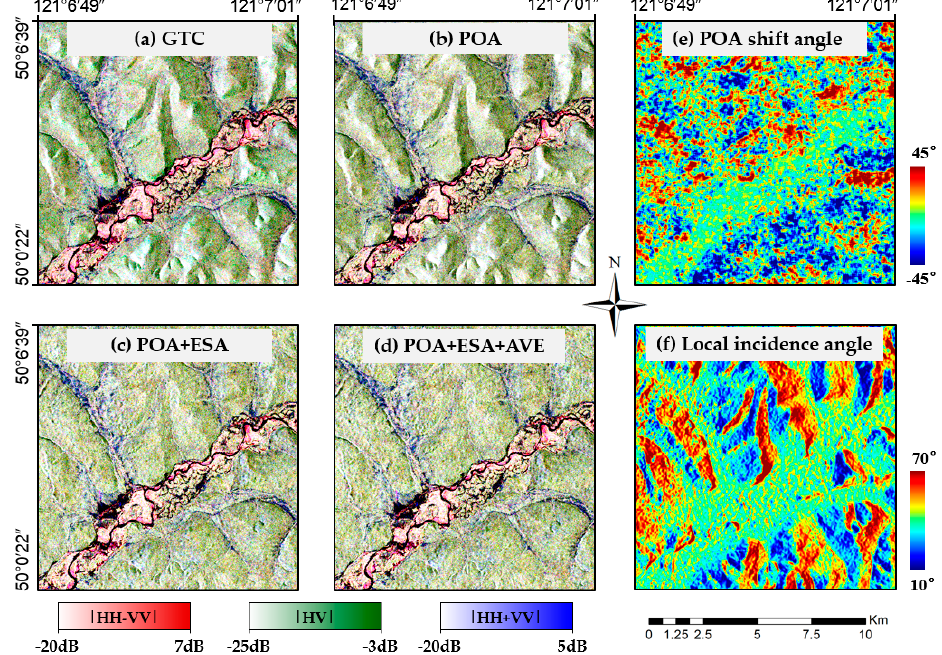
Figure 16. Enlarged image of the PolSAR Pauli RGB after each correction step: ( a ) GTC (before correction); ( b ) POA correction; ( c ) POA + ESA correction; ( d ) POA + ESA + AVE correction; ( e ) POA shift angle and ( f ) local incidence angle.